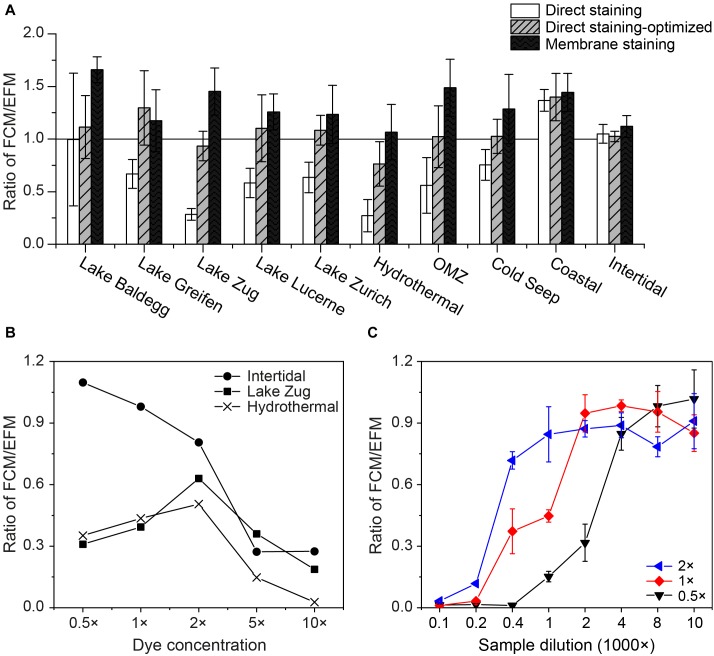
(A) Comparisons of FCM counts using different staining approaches: direct staining of using 1 × SYBR-I, 1000× sample dilution (white bars); direct staining after optimization, i.e., using D/S ratios of 2,000–8,000 (gray bars with slashes); membrane staining (black bars). To facilitate the comparisons, all of the FCM counts were normalized to the corresponding EFM counts by dividing FCM- by EFM-based numbers. Hence, a value of 1.0 indicates equal cell counts by FCM and EFM. At least three samples from each location shown in Table 1 were selected for tests. (B) Relationship between the dye concentrations used for direct staining and their FCM counts. Samples from Lake Zug, Hydrothermal area, and intertidal zone were selected, due to the extremely low (or high) staining efficiencies of these samples found in the initial tests. (C) Impact of sample dilution on direct staining of cell extracts, when 0.5×, 1×, 2 × SYBR-I were applied. Sediments from Lake Zug (6–8 cm) were used for tests. Error bars are standard deviations derived from triplicates.